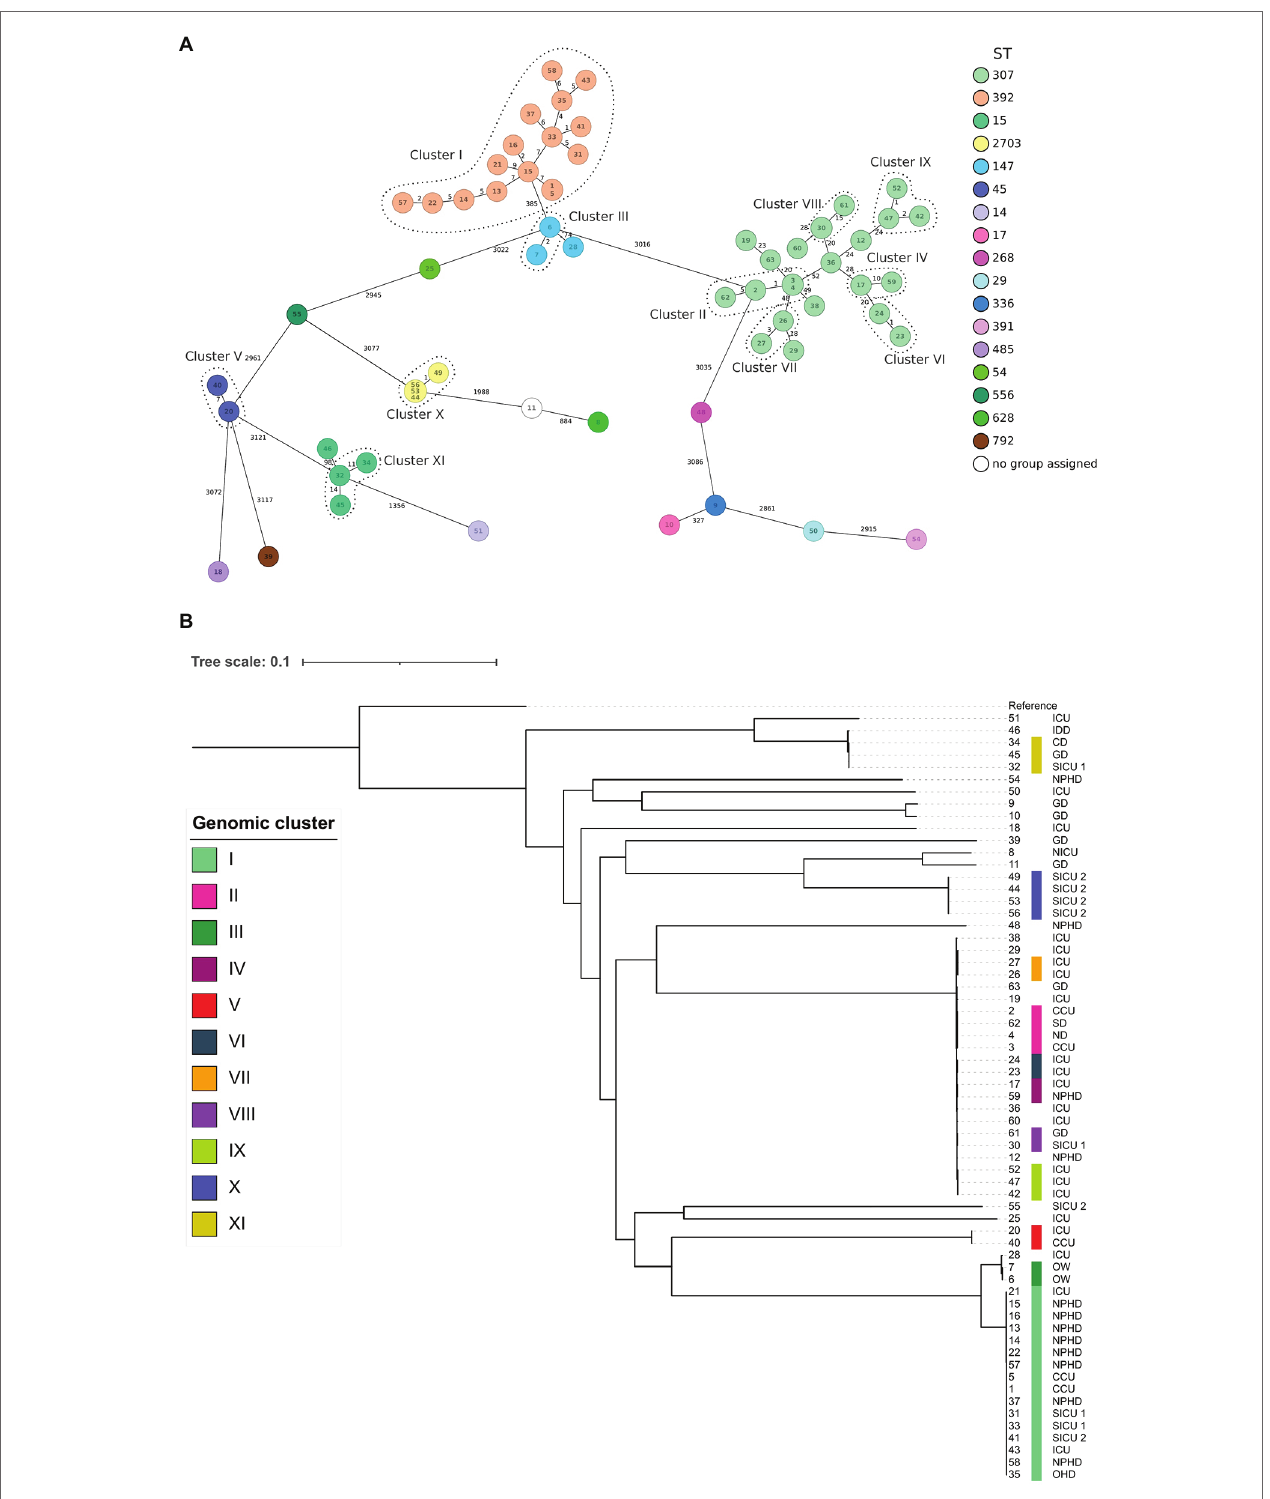
FIGURE 1 | (A) Minimum spanning tree of extended-spectrum β -lactamase-producing Klebsiella pneumoniae (ESBL-Kp) isolates ( N = 63) showing identified clusters (roman numerals and encircled dotted lines) and allele distance between strains based on cgMLST analysis of 2,358 genes. Each sequence type (ST) assigned is indicated with a different color. Branch lengths are not to scale. (B) Maximum-likelihood phylogenetic tree obtained from cgSNP analysis of ESBL-Kp isolates showing identified clusters (roman numerals and color legend). Hospital locations are also indicated (CCU, cardiac care unit; CD, cardiology